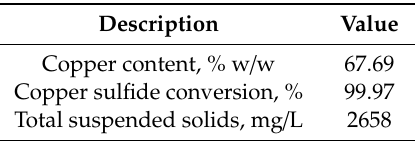
Table 1. Sulfidization